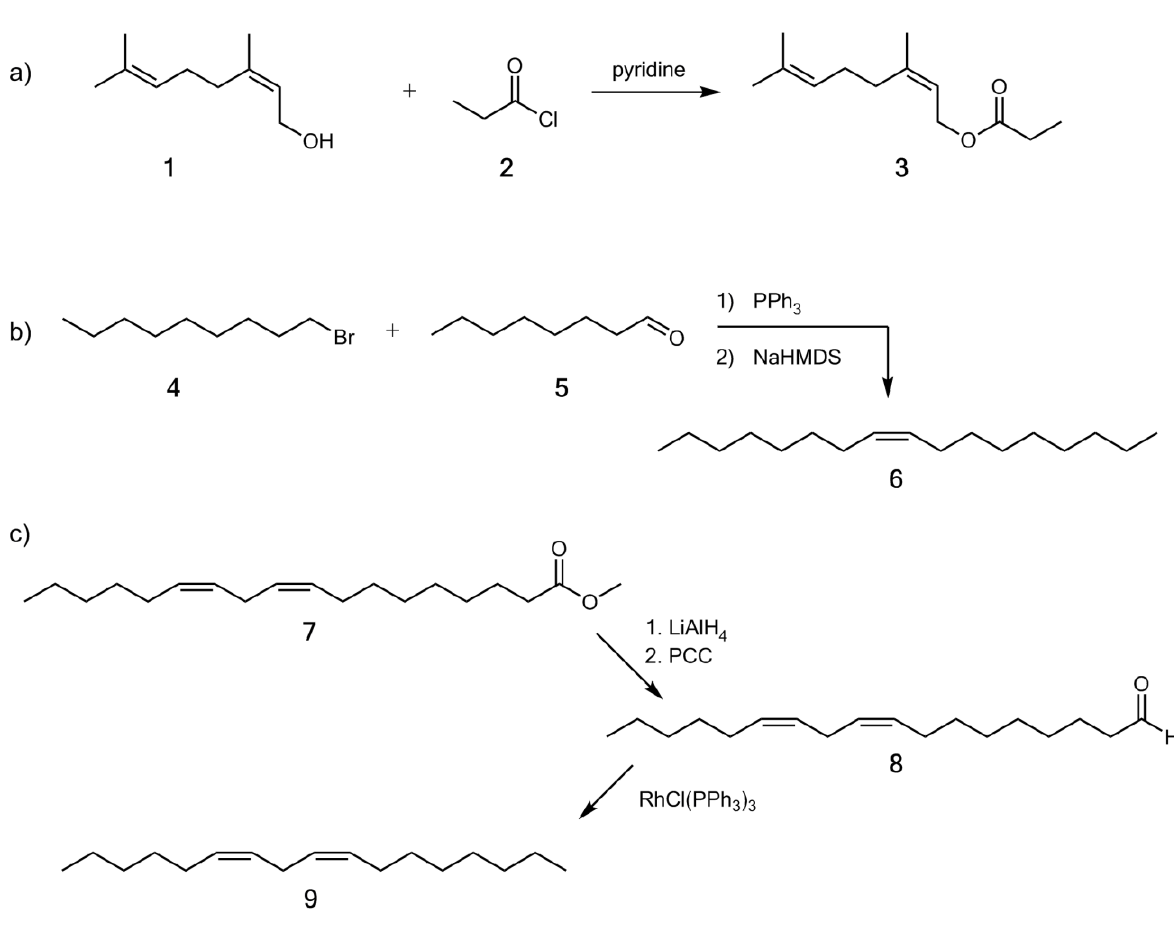
Figure 1. ( a ) Synthesis of neryl propionate ( 3 ); ( b ) Synthesis of ( Z )-8-heptadecene ( 6 ); ( c ) Synthesis of (6 Z ,9 Z )-6,9-heptadecadiene ( 9